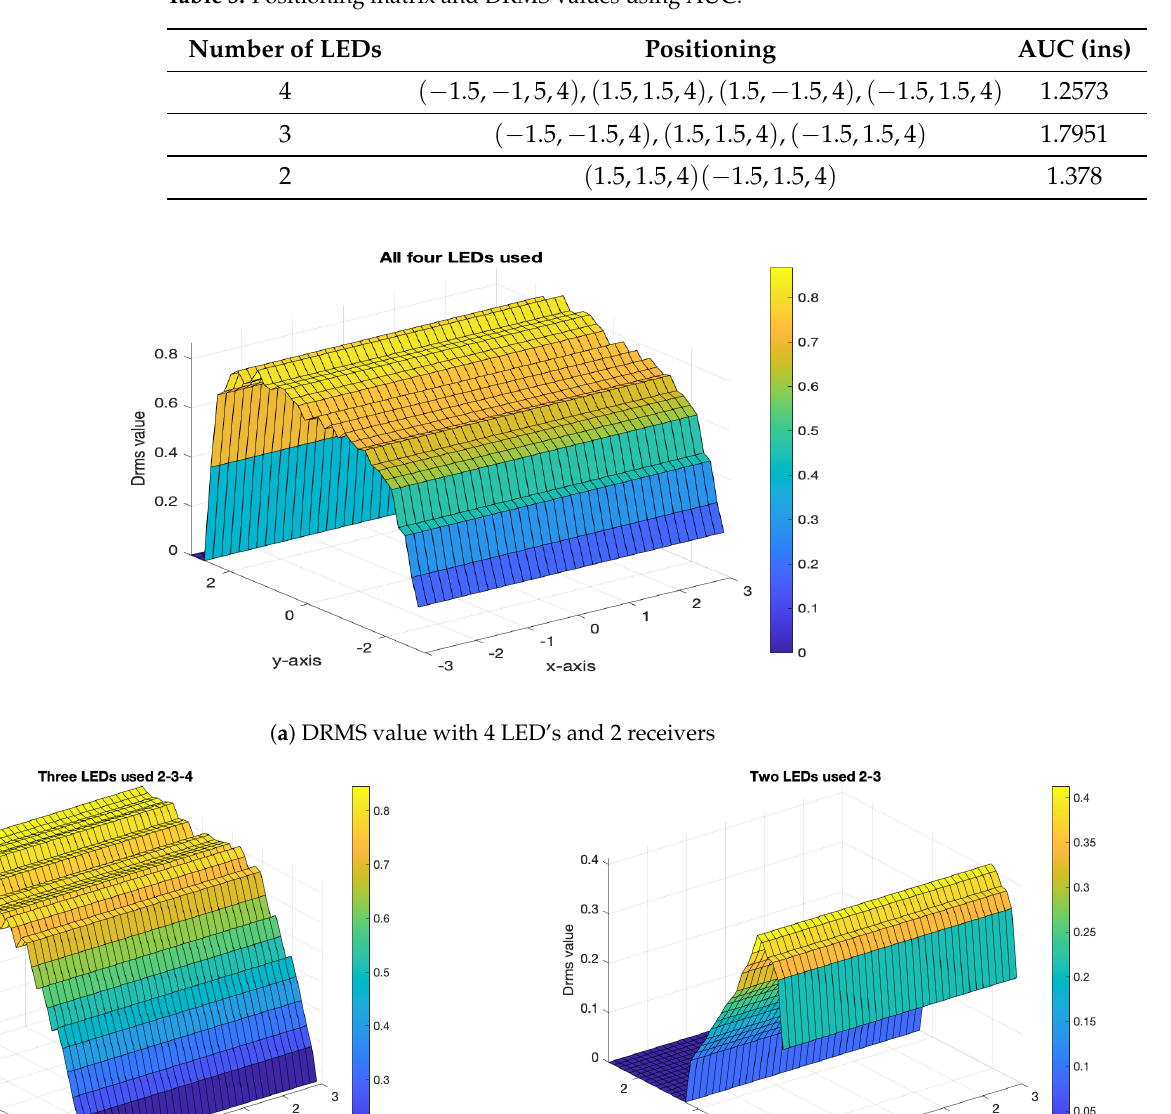
Table 3. Positioning matrix and DRMS values using AUC.